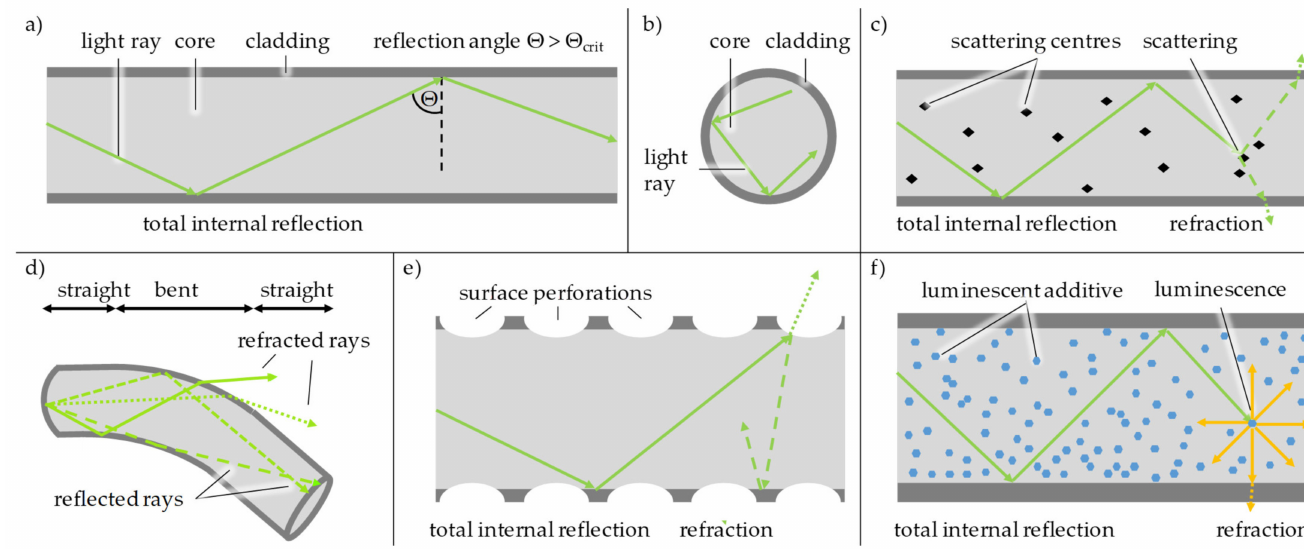
Figure 1. Reflection and refraction in optical fibers: ( a ) total internal reflection (TIR) from axial view, ( b )TIR from cross- sectional view, ( c ) refraction due to bulk scattering, ( d ) refraction due to bending, ( e ) refraction due to surface perforations and ( f ) refraction due to